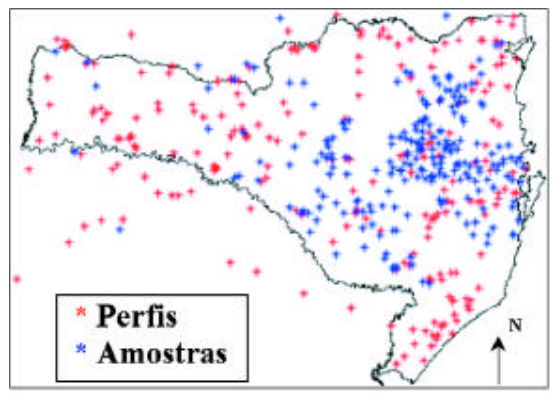
Figura 1. Distribuição dos perfis completos e amostras complementares utilizados no